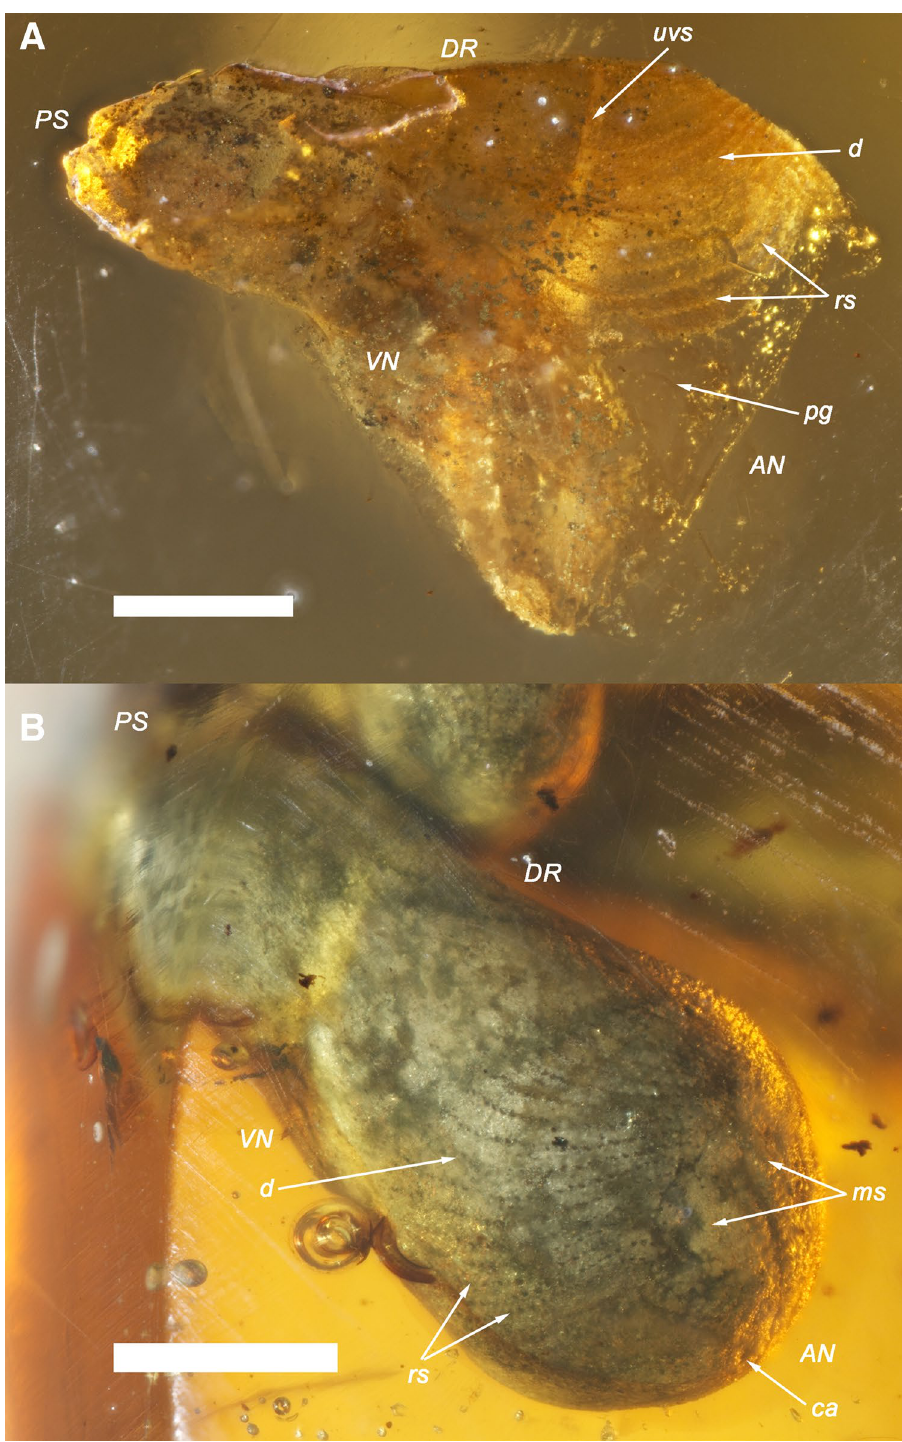
Figure 3. Holotype and a paratype of † Palaeolignopholas kachinensis gen. & sp. nov. from lower Cenomanian Kachin amber, northern Myanmar. ( A ) Holotype: ventro-lateral view of articulated shell. ( B ) Paratype: anterio- lateral view of fossilized shell. VN ventral margin; DR dorsal margin; AN anterior margin; PS posterior margin; d disc; rs rasping surface of the valve; uvs umbonal ventral sulcus; pg pedal gape; pl periostracal lamellae. Scale bars = 500 µm. (Photos: Ilya V.